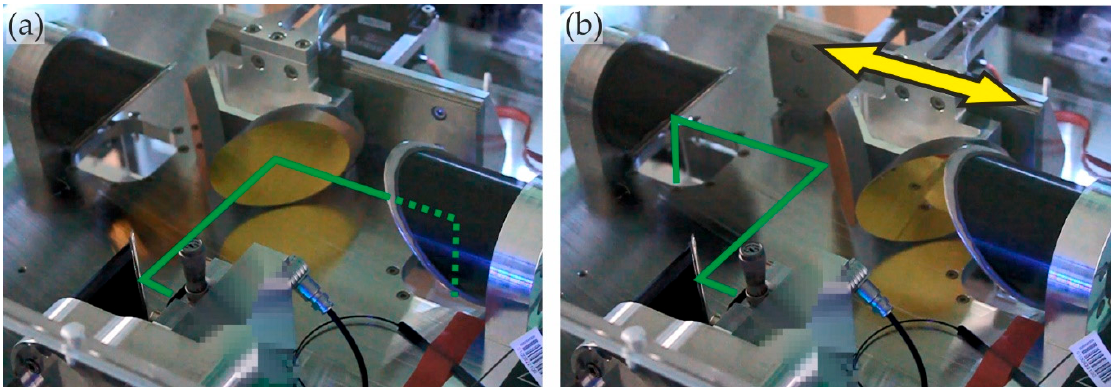
Figure 6. Side swap mechanism. Two 45° plane mirrors (forming a prism-like reflector) are located on a servo-driven linear stage to enable the scanning of a DIN C4 envelope with a reduced system footprint. The switching of the terahertz beam path to achieve the two possible measurement locations ( a and b , respectively) is indicated.